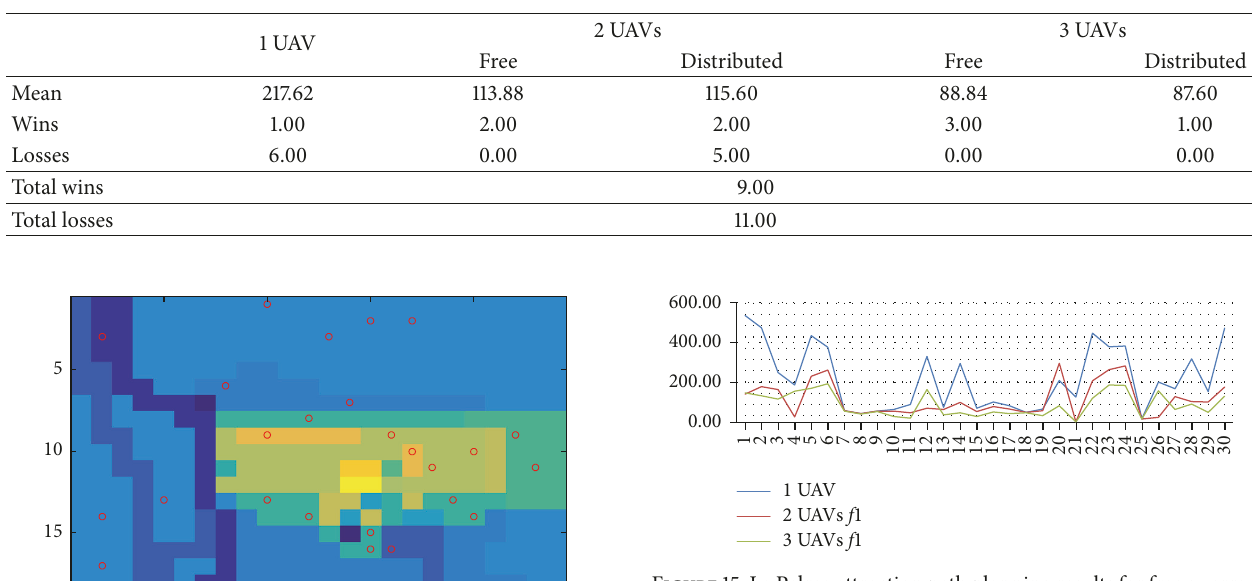
Table 8: Time results with attraction strategy.